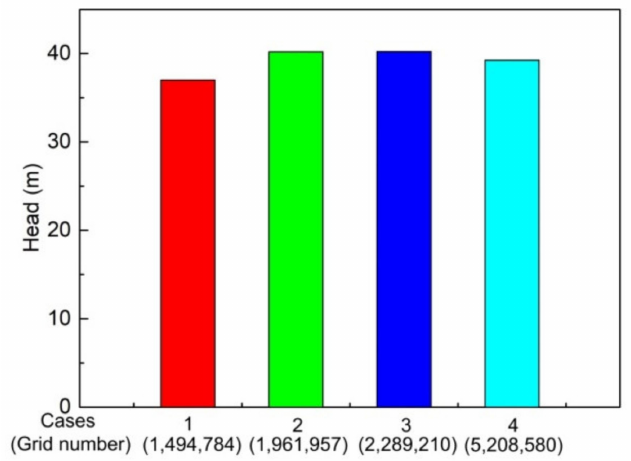
Figure 3. Assessment of mesh